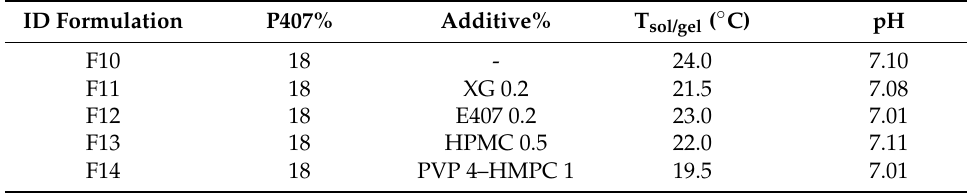
Table 2. T sol-gel and pH of P407 formulations with additives prepared in PBS 1 ×